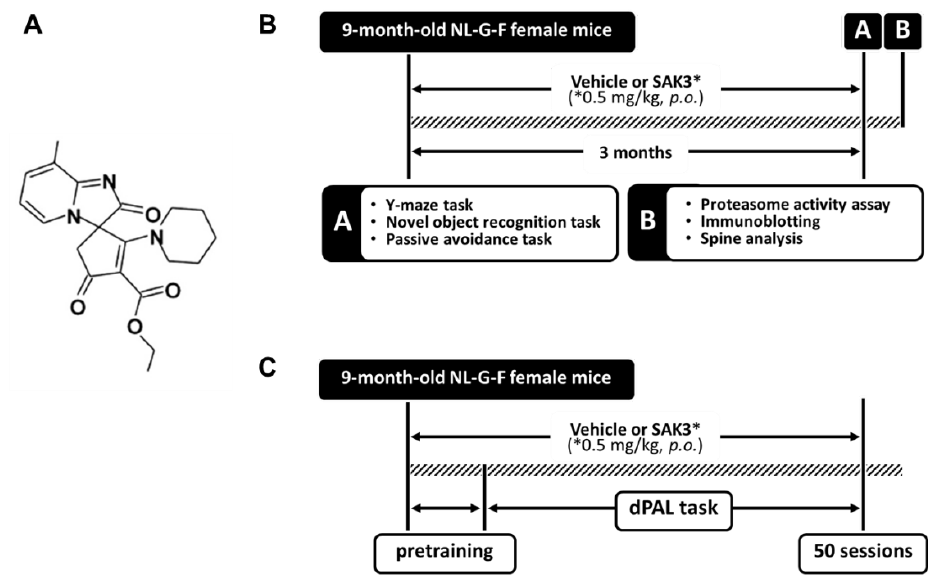
Figure 1. Chemical structure of SAK3 and the experimental schedule. ( A ) Chemical structure of SAK3. ( B , C ) Experimental schedule of this study. * Dose of SAK3.